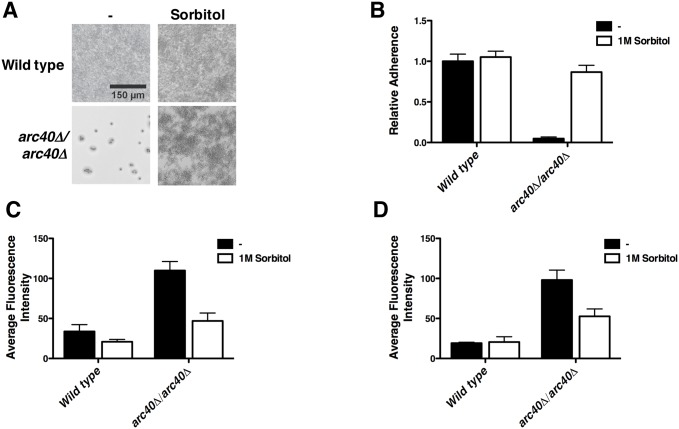
The Arp2/3 complex plays a critical role in maintaining cell wall integrity.(A-B) Osmotic stabilization with sorbitol rescues adherence defect of Arp2/3 complex mutants. Cells were grown in YPD ± 1M sorbitol at 30°C and adherence assay was performed as described in Fig 1C. Representative microscopy images of 96-well adherence assay are shown (A) and quantification of adherence is plotted in (B). Error bars represent standard deviations of nine technical measurements. Sorbitol significantly restores the ability of the arc40Δ/arc40Δ mutant to adhere to a solid surface (P<0.001, ANOVA, Bonferroni's Multiple Comparison Test). (C-D) Treatment with sorbitol restores chitin (C) and glucan (D) content in the cell wall of an arc40Δ/arc40Δ mutant to wild-type levels. Microscopy was performed as described in Fig 3A. Fluorescence intensity was quantified. Error bars represent standard deviations of five technical measurements. Significant differences in fluorescence intensity upon staining with Calcofluor White and Aniline Blue were observed in an arc40Δ/arc40Δ mutant in the absence and presence of sorbitol (P<0.001, ANOVA, Bonferroni's Multiple Comparison Test).